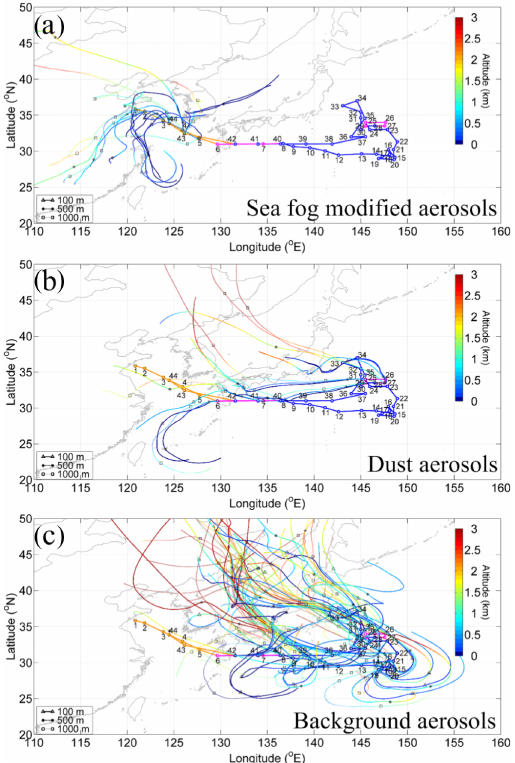
Figure 4. Map and cruise track superimposed on 3-day air mass backward trajectories corresponding to each sample. Altitudes of 100ma.s.l. (triangles), 500ma.s.l. (asterisks) and 1000ma.s.l. (squares) are above sea level during the collection of (a) sea-fog- modified aerosols, (b) dust aerosols and (c) background aerosols. The color bar represents the altitude (in km).